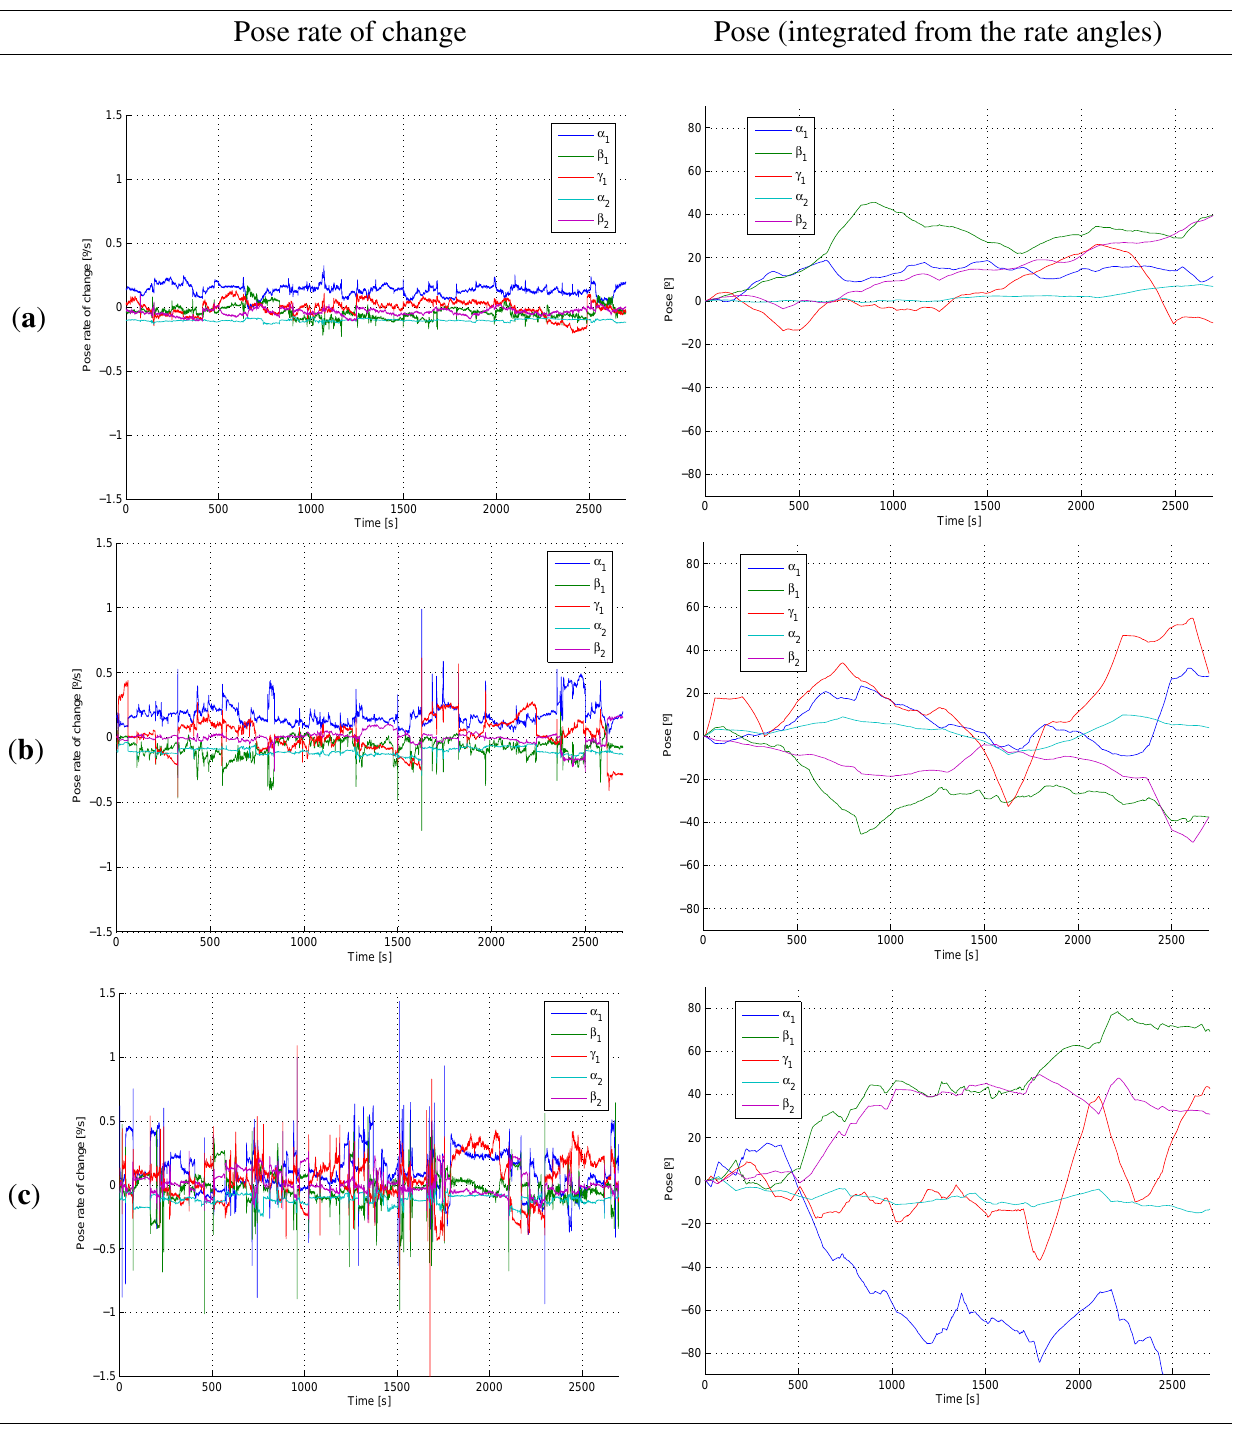
Figure 12. Pose rate of change and pose computed from the integral of the pose rate without reset conditions for the awake ( a ); semi-drowsy ( b ) and drowsy ( c ) drivers, corresponding to test subjects 1, 6 and 11,